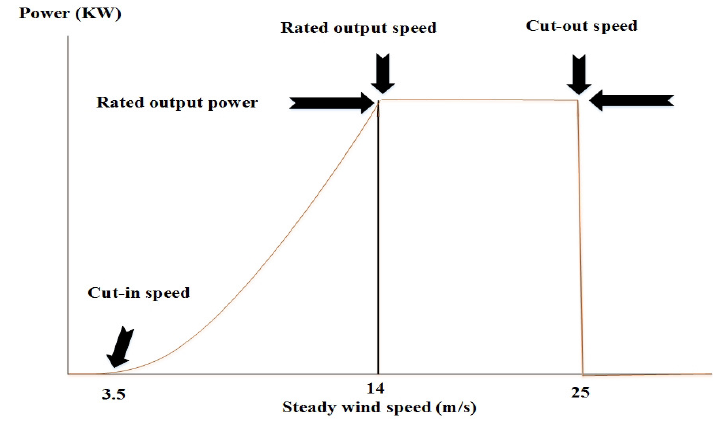
Figure 1. Wind turbine power output and wind speed